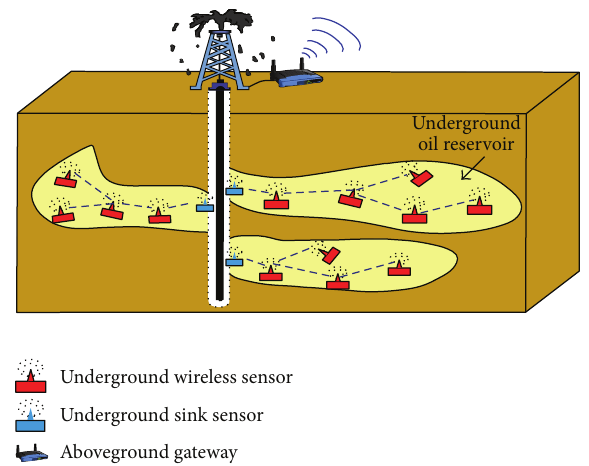
Figure 1: System architecture of the wireless sensor network for oil